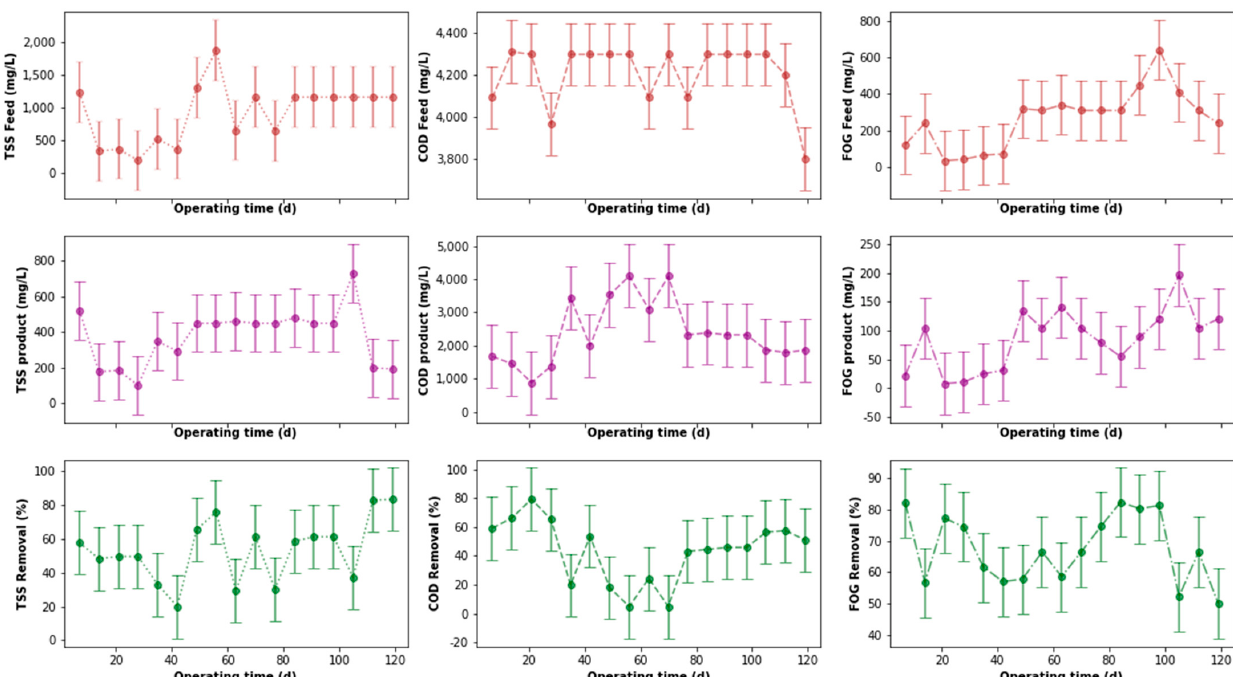
Figure 6. Pre ‐ treatment performance after anomaly detection and correction.